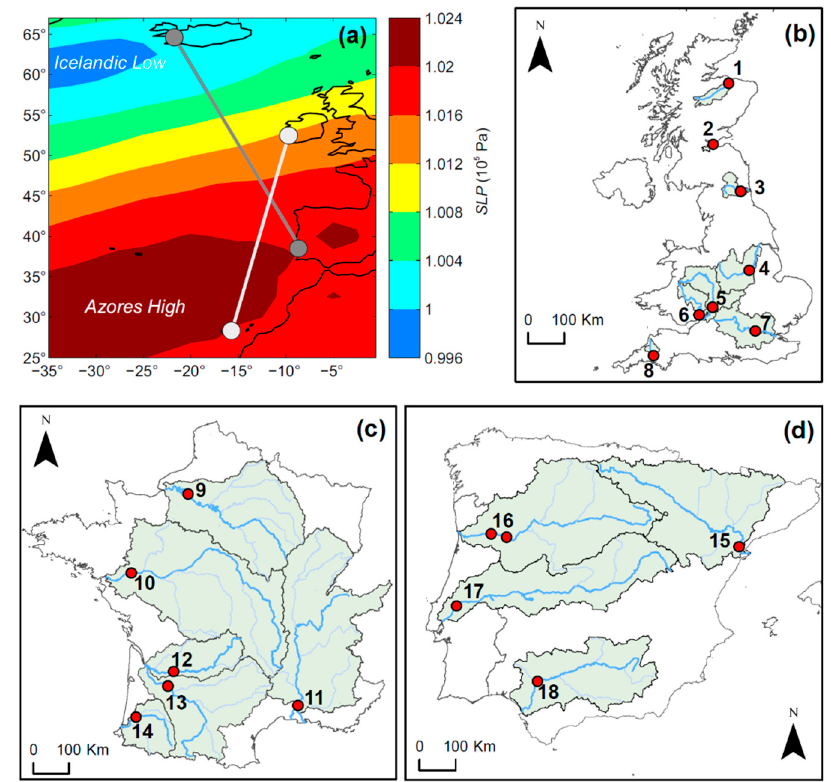
Figure 1. ( a ) Winter-averaged sea-level pressure (SLP) in the northeastern Atlantic Ocean. Dark-gray and light-gray circles indicate the North Atlantic Oscillation (NAO) and West Europe Pressure Anomaly (WEPA) indices, respectively, defined as the normalized gradient of sea-level pressure between two given stations. ( b – d ) Location of the eighteen rivers under study (Table 1) and their catchment boundaries ( a ) in United Kingdom, ( b ) France, and ( c ) Iberian Peninsula. Red dots indicate the locations of river-flow gauges.